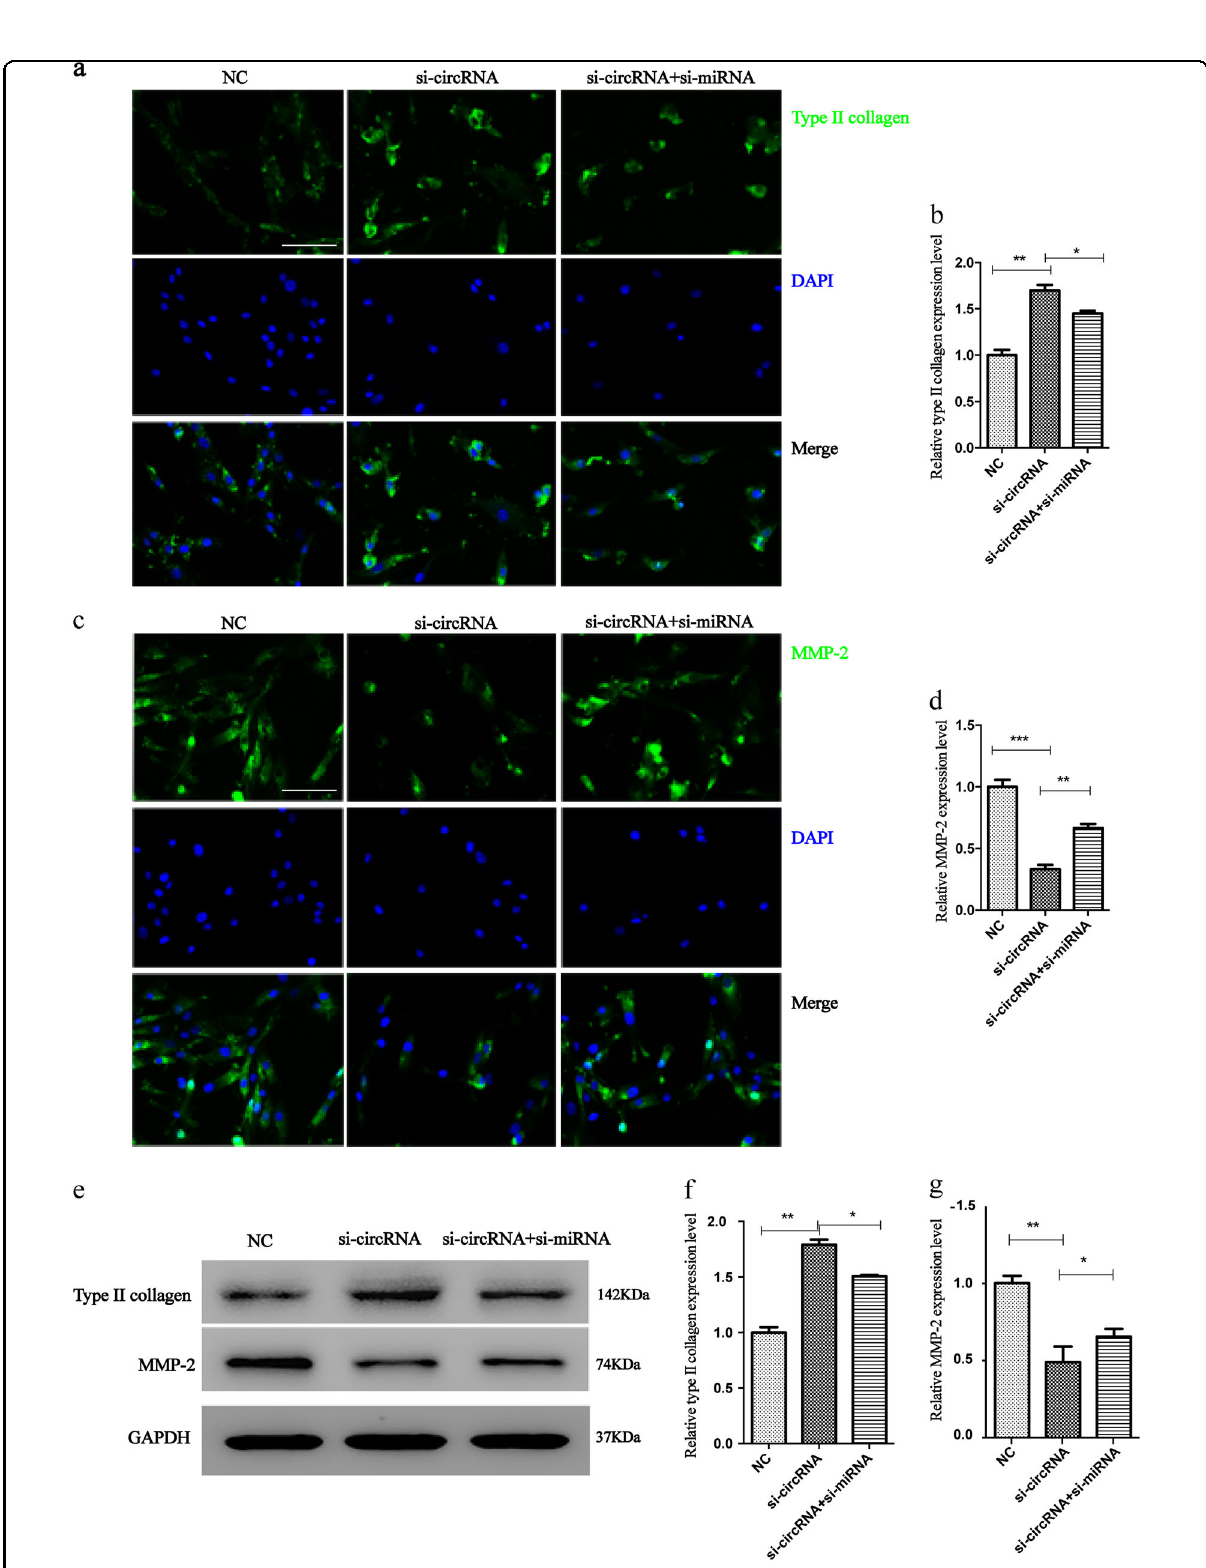
Fig. 5 circRNA_104670 promotes the expression of MMP-2 and inhibits the expression of collagen II. a , b Immuno fl uorescence staining for collagen II after transfection with si-circRNA_104670 or co-transfection with si-circRNA_104670 and si-miRNA-17-3p, scale bar, 40 μ m. c , d Immuno fl uorescence staining for MMP-2 after transfection with si-circRNA_104670 or co-transfection with si-circRNA_104670 and si-miRNA-17- 3p, scale bar, 40 μ m. e – g Collagen II and MMP-2 protein expression levels were analyzed by Western blotting. GAPDH was used as a loading control. The presented values are the means ± SD. of three different preparations, * p < 0.05; ** p < 0.01; *** p <